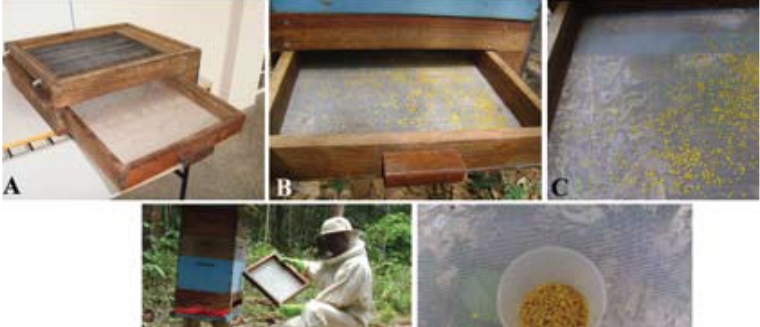
.Fig. 2 ( A ) . Internal or top pollen collectors. ( b ) Collector tray of pollen. ( C ) Detail of the amount of pollen grains collected per hour. ( D ) . Collection procedure of the pollen